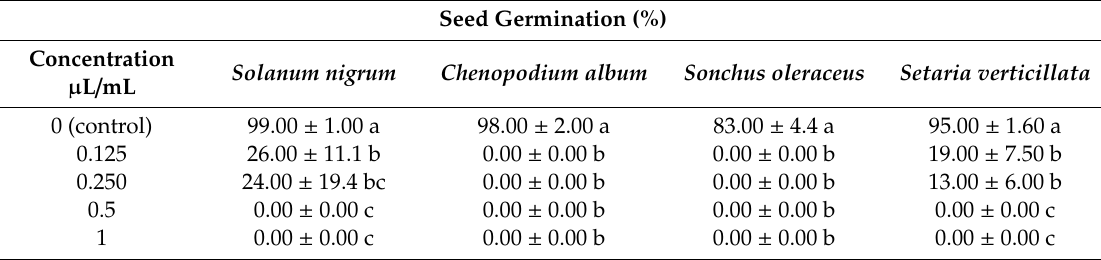
Table 3. Phytotoxic e ff ects of Thymbra capitata EO (TC3) on Solanum nigrum , Chenopodium album , Sonchus oleraceus and Setaria verticillata seed germination.